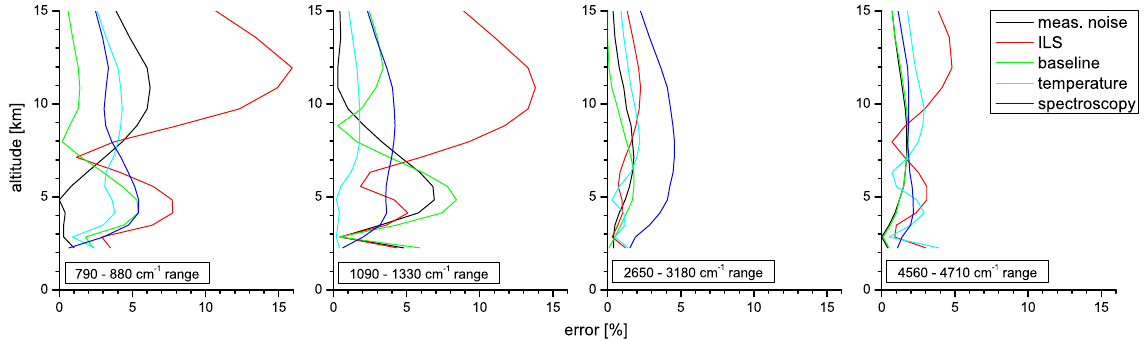
Fig. 7. Estimated H 2 O random profile errors for the retrievals in the four different spectral regions. Black: measurement noise; Red: ILS; Green: baseline offset; Cyan: temperature profile; Blue: spectroscopic parameters.